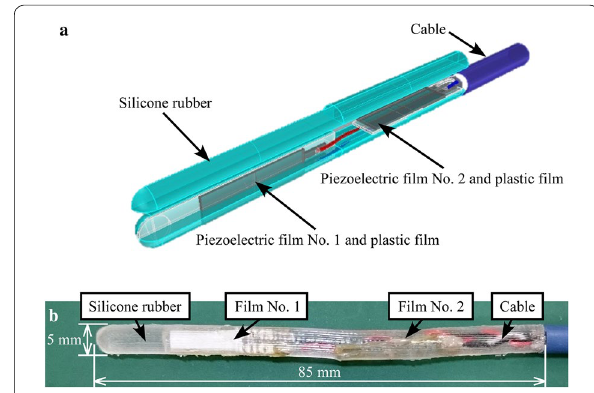
Fig. 16 Prototype of biaxial catheter-type tactile sensor. a Schematic diagram. b